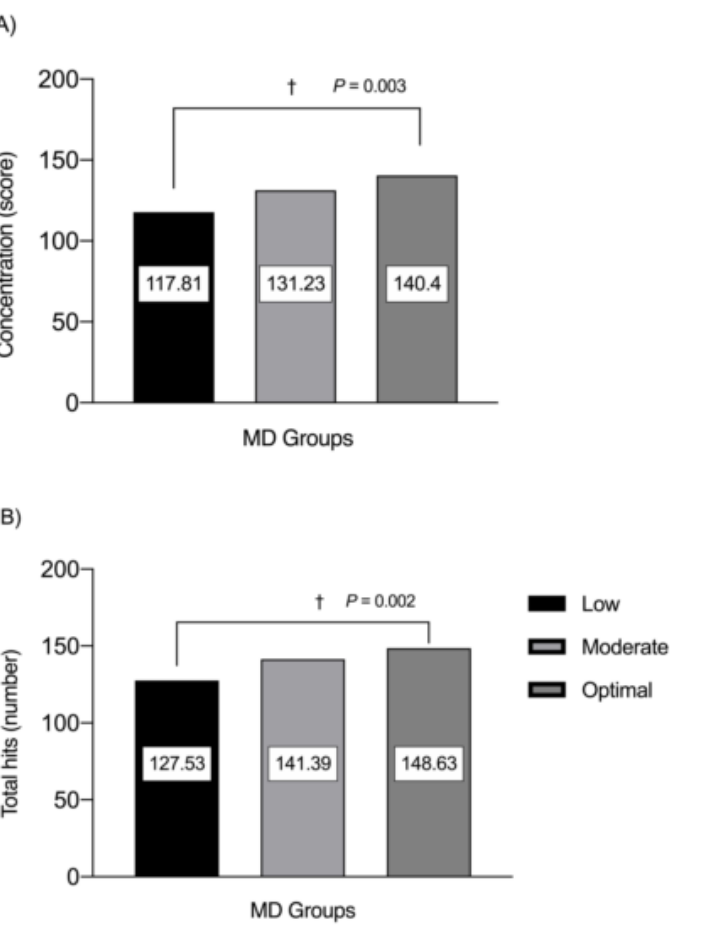
Figure 3. Concentration ( A ) and total hits ( B ) scores in schoolchildren participants by MD groups (low, moderate and optimal). (†) Daggers denotes significant differences by group at each respective p -value.